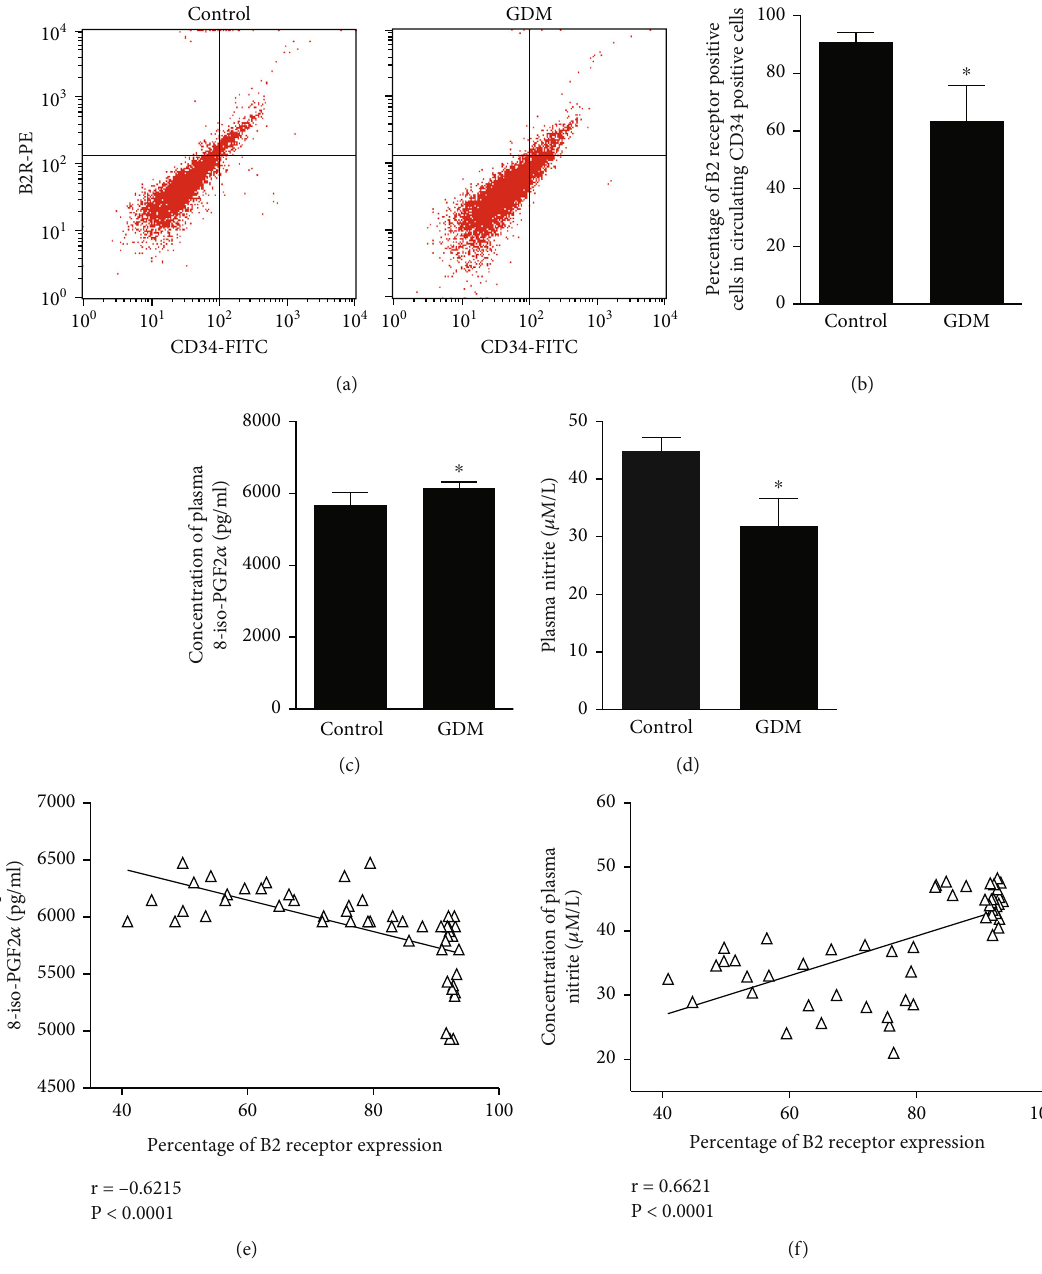
Figure 1: Expression of B2R in CD34 + cells of CBMCs from newborns with or without mothers with GDM. (a) Typical histograms of fl ow cytometric analysis of B2R expression in CD34 + cells of CBMCs from newborns with or without mothers with GDM. (b) Quanti fi cation of B2R expression by fl ow cytometry. (c) The 8-iso-PGF2 α concentration was detected by a Direct 8-iso- PGF2 α ELISA kit. (d) NO production was detected by NO assay kit. (e) Correlation between plasma 8-iso-PGF2 α concentration and B2R expression. (f) Correlation between plasma NO concentration and B2R